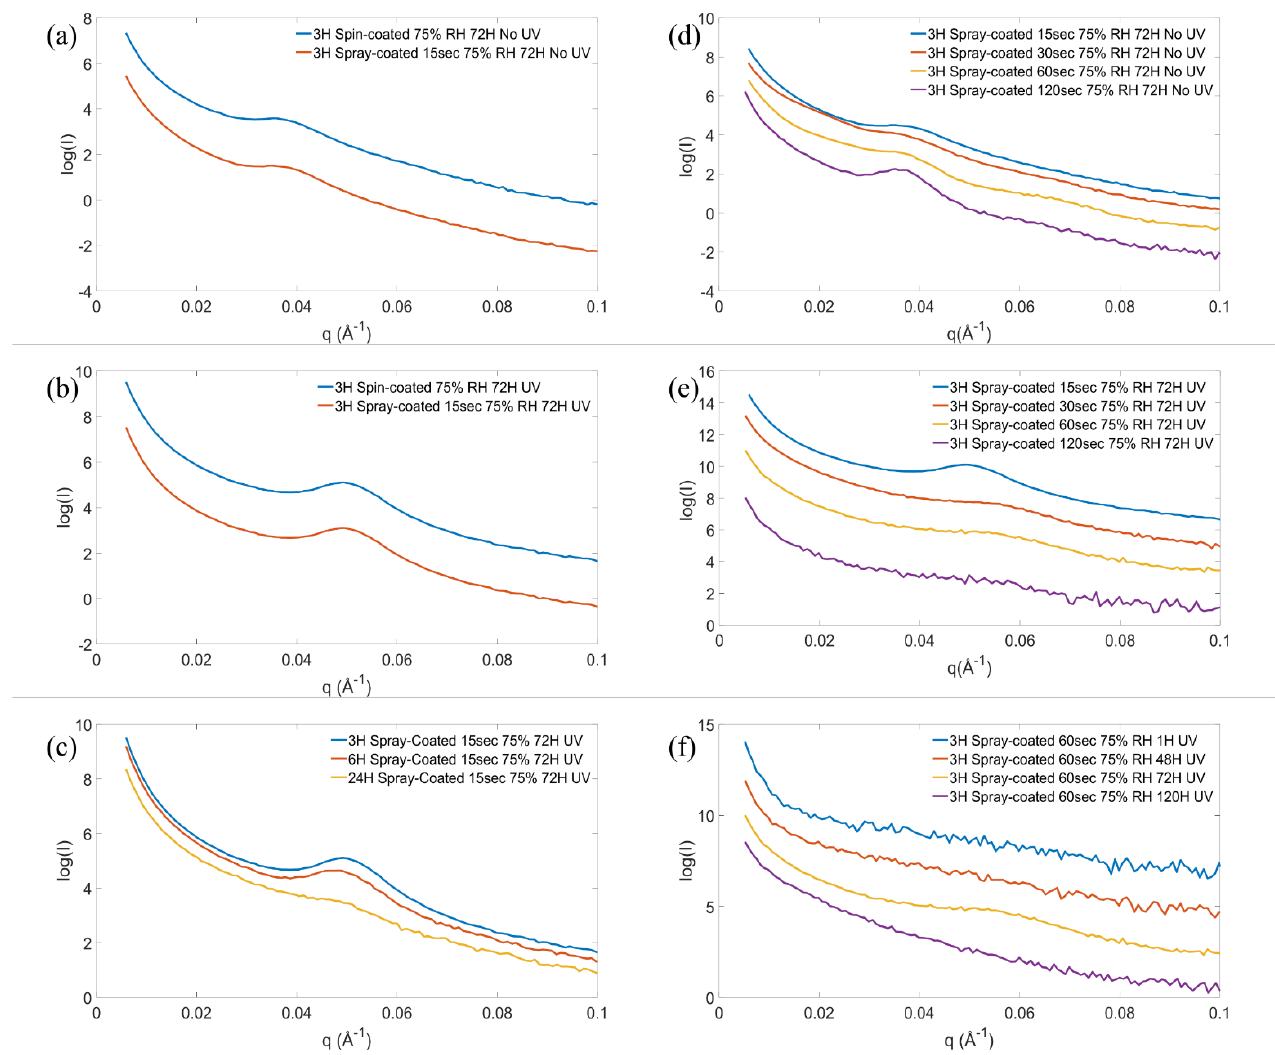
Figure 2. SAXS patterns of samples prepared with either spin coating or 15 s of spray coating from solution with 3 h synthesis time, before template removal ( a ) and after template removal ( b ). SAXS patterns of 15 s spray coated films prepared from solution with reaction times from 3 to 24 h, after template removal ( c ). Patterns of films with 15–120 s spray coated films before ( d ) and after template removal ( e ). SAXS patterns of 60 s spray coated films with aging time 1–120 h at 75% RH ( f ). The patterns are shifted in intensity for clarity.